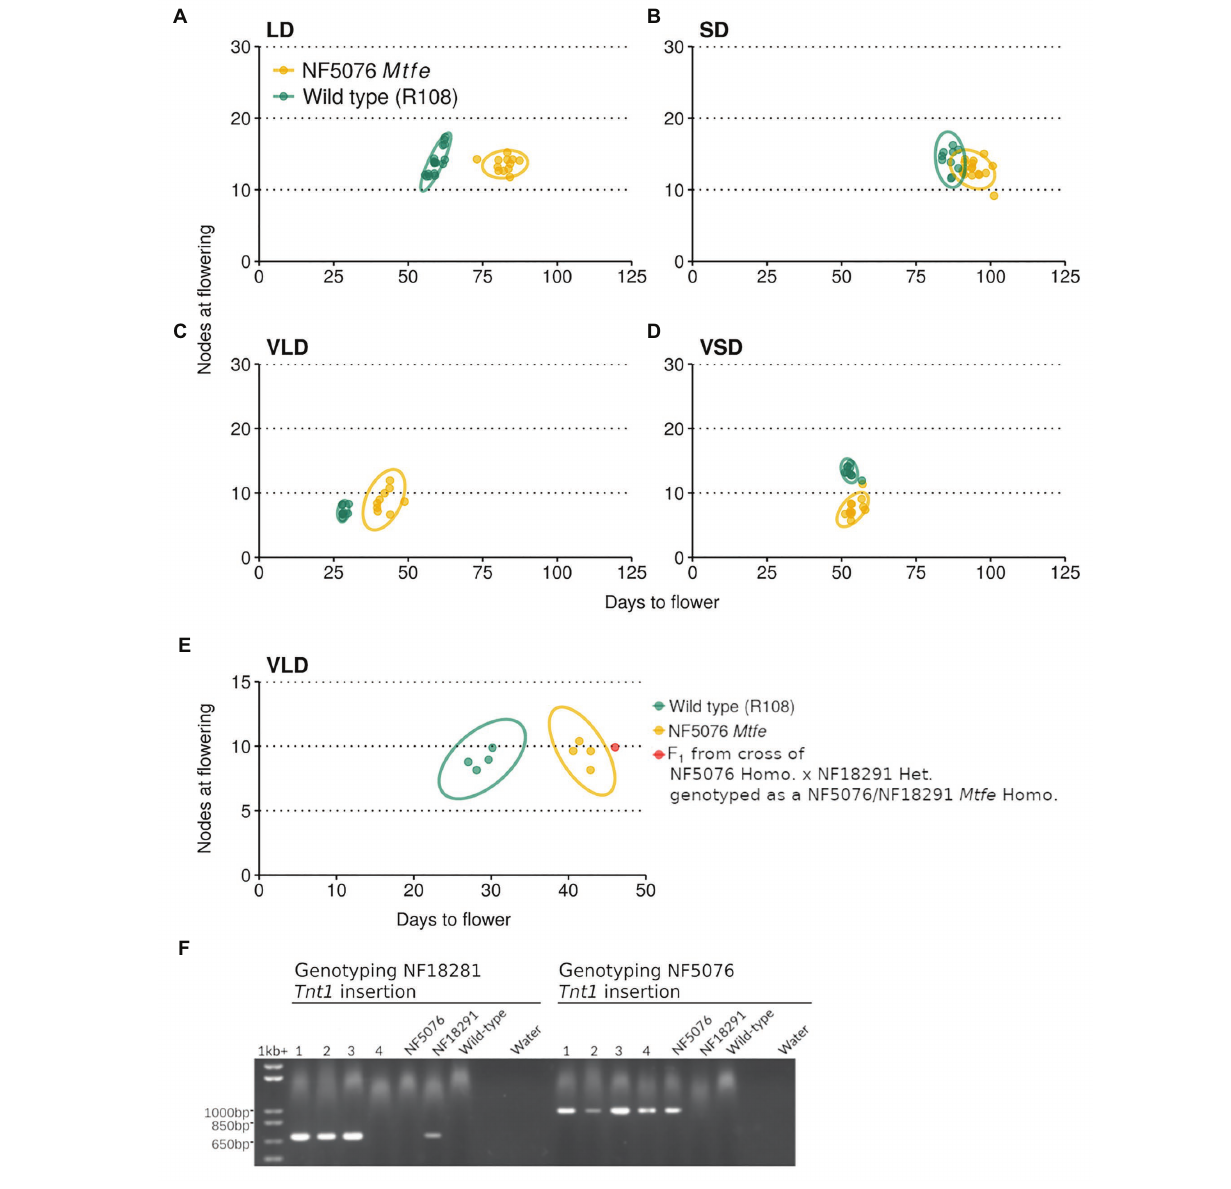
FIGURE 4 | NF5076 Mtfe mutants have delayed flowering relative to wild type in days when grown in LD and VLD. The flowering time of M. truncatula NF5076 Mtfe mutants ( n = 7–12) grown in (A) LD, (B) SD, (C) VLD, and (D) VSD are plotted relative to the wild type R108. (E) plots the flowering time in VLD of a NF5076 Mtfe x NF18291 Mtfe F 1 plant relative to NF5076 Mtfe and wild type R108 plants. Note that heterozygous plants from both mutant lines flower at a similar time to wild type R108 ( Supplementary Figures S2, S4 ). (F) Genotyping of the four F1 progeny from a cross of homozygous NF5076 Mtfe mutants with a heterozygous NF18291 plant, showing that three of the F1 plants (lanes 1–3) are bi-allelic mutants. Of these three plants, one survived and two died prior to flowering. Genotyping of the NF18291 insertion utilized the Tnt1_R/Medtr6g444980_2127_R primer pair which specifically amplifies a 760 bp product. Genotyping the NF5076 insert used the Tnt1_F/Medtr6g444980_2127_R primer pair with a 1,001 bp product. Flowering time graphs are plots of days to flower against nodes on the primary axis at the time of flowering. Each point represents an individual plant. Variation is indicated by 95% confidence ellipses (2D analog of a confidence